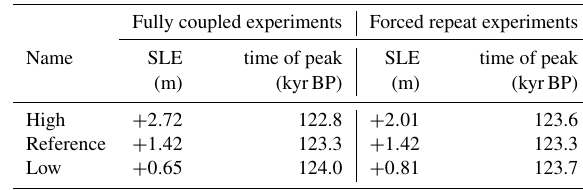
Table 2. Peak sea-level contribution in sea-level equivalent (SLE) and timing from the Greenland ice sheet above present-day levels for three different parameter